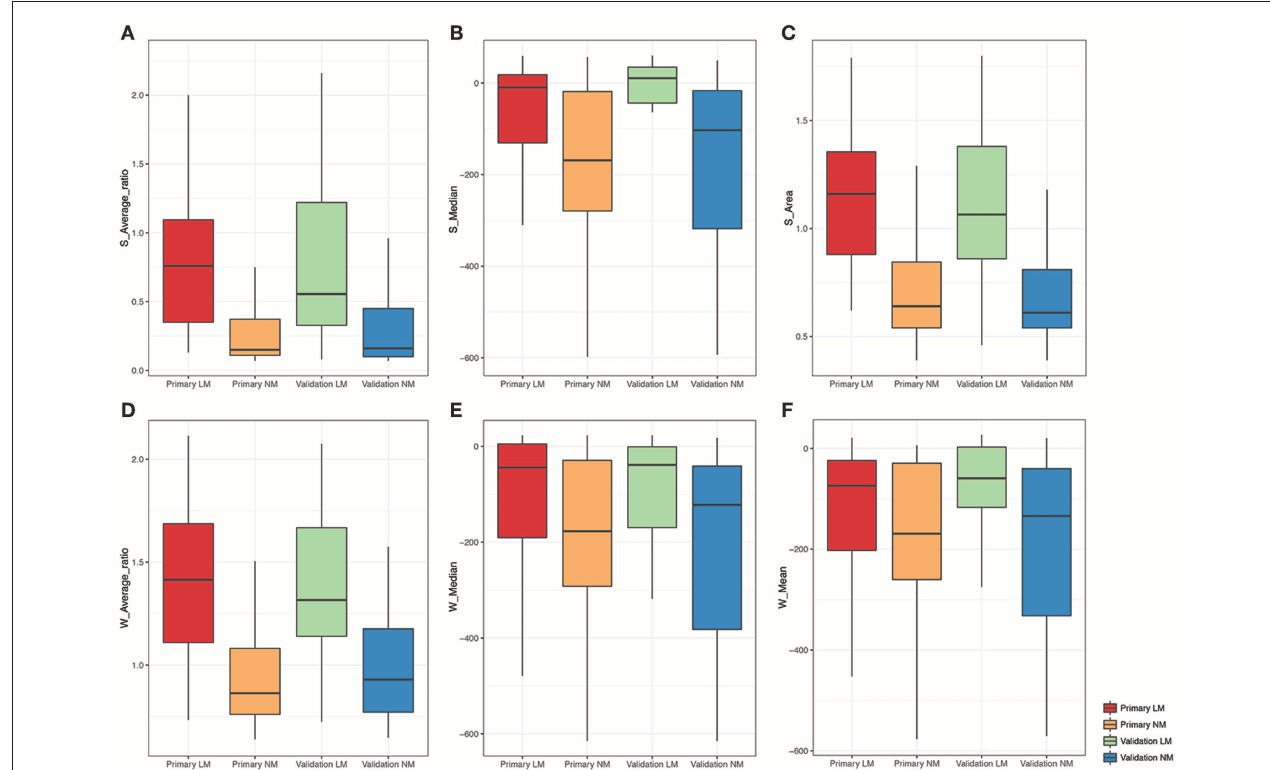
FIGURE 2 | Boxplot of the selected histogram parameters in the LM and NM group. (A–C) Boxplot of the S-Average ratio, S-Median, S-Area from the single-slice histogram in the LM and NM group, respectively. (D–F) Boxplot of the W-Average ratio, W-Median, W-Mean from the whole-lesion histogram in the LM and NM group,